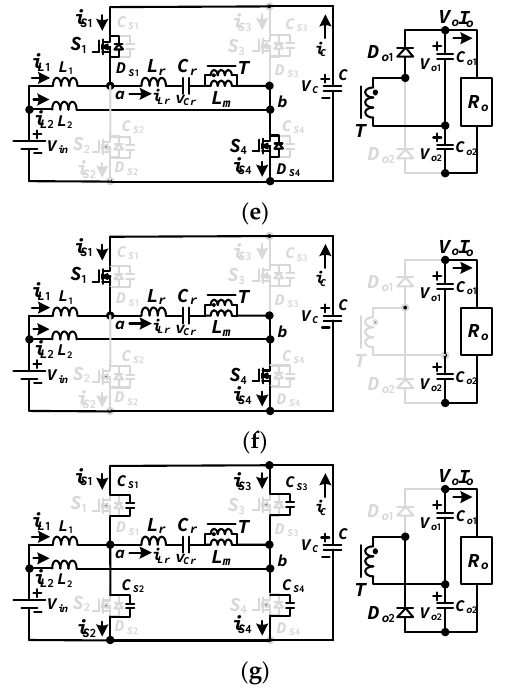
Figure 2. Converter operated at low input voltage mode ( a ) main pulse-width modulation (PWM)